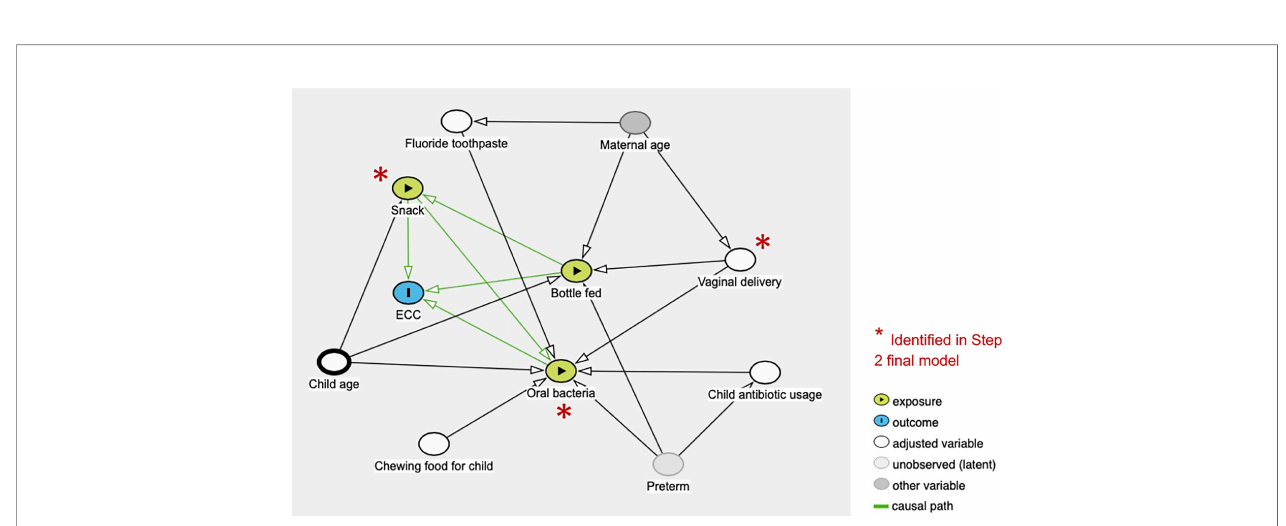
FIGURE 7 | Conceptual causal inference from multiplatform variables assessed in the study.